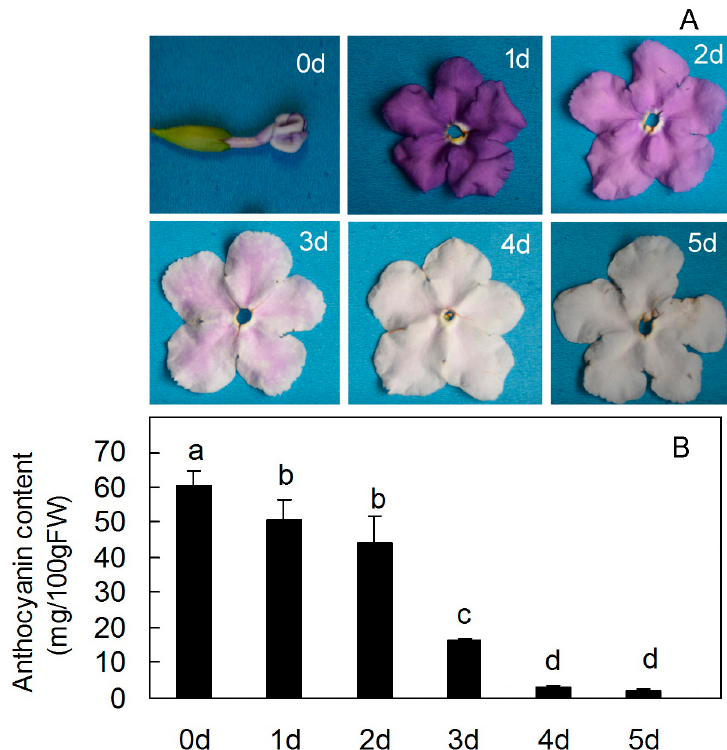
Figure 1. Change in anthocyanin content in petals at sequential stages of flower opening and senescence over 6 days. ( A ) Brunfelsia acuminata petals at sequential stages of flower opening and senescence over 6 days; ( B ) The anthocyanin content at sequential stages of flower opening and senescence over 6 days. The data represent means ± SD of three replicate ( n = 3). Where no error bars are present, The SD was smaller than the size of the symbol. Different letters indicate significant differences ( p < 0.05).